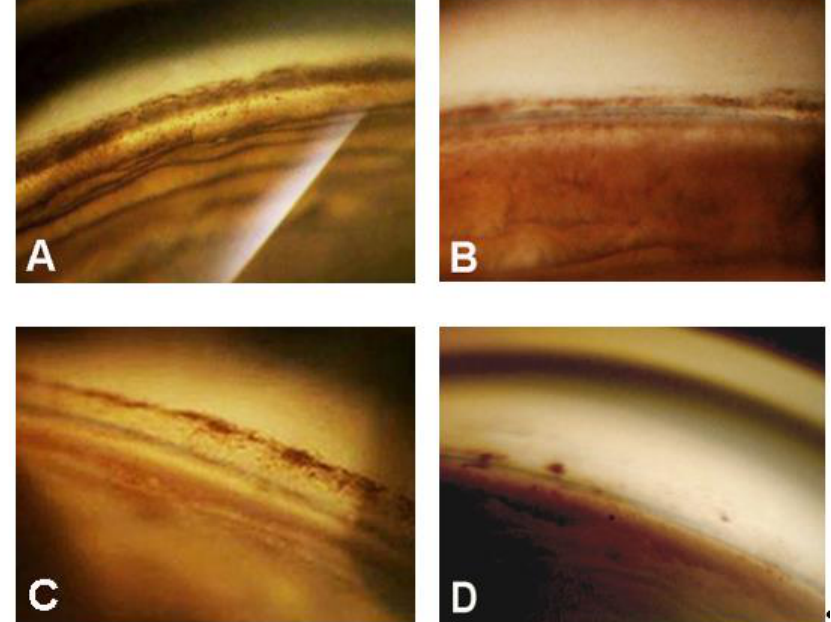
Figure 5. ( A ) Preoperative gonioscopic view of the trabecular meshwork in a 46-year-old man with pigmentary glaucoma; B and C significant reduction of trabecular pigment, one year ( B ) and two years ( C ) after canaloplasty; ( D ) almost complete reabsorption of trabecular pigment three years after surgery.